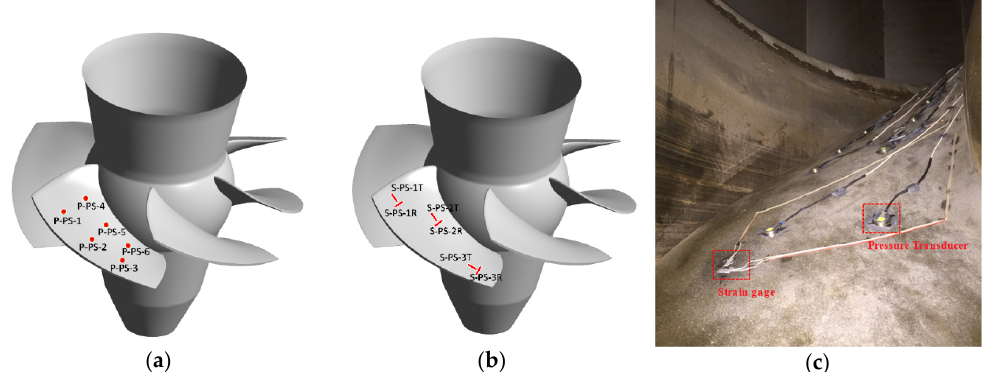
Figure 1. ( a ) Position of the pressure transducers on the runner blade pressure side [20], ( b ) position of the strain gages on the runner blade pressure side [20], ( c ) the blade runner pressure side before applying the epoxy.